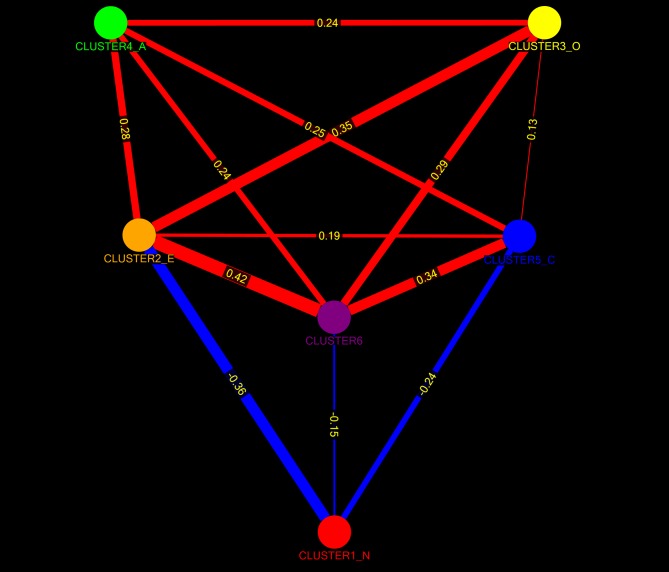
The Personality Web at cluster level: network graph showing correlations between cluster scores calculated using the network community structure from
Figure 5
.CLUSTER1_N, CLUSTER2_E, CLUSTER3_O, CLUSTER4_A, CLUSTER5_C: clusters showing maximum correspondence with standard clusters of Neuroticism, Extraversion, Openness, Agreeableness and Conscientiousness, respectively. CLUSTER6: newly found sixth factor (see Figure 5, Table 4 and Discussion). Network graph is shown at p<0.01 corrected for multiple comparisons. The thickness of the links represents the strength of the correlation coefficient. Correlation coefficients are shown alongside the links. Red: positive correlations, blue: negative correlations. For further information, see Table 4A. CLUSTER1_N, the Neuroticism analogue, has only negative (inhibitory) influences on the remaining network structure, which shows only positive interrelations. Personality Webs such as these may represent developmental structures. CLUSTER2_E (Extraversion analog), CLUSTER5_C (Conscientiousness analog) and the 6th cluster form an intermediate structure in between CLUSTER1_N (Neuroticism analog) and CLUSTER4_A and CLUSTER3_O (the Agreeableness and Openness analogs). This suggests that the negative influence of Neuroticism on Agreeableness and Openness scores, as observed in personality disorders, is mediated by this intermediate level (see discussion for further details).